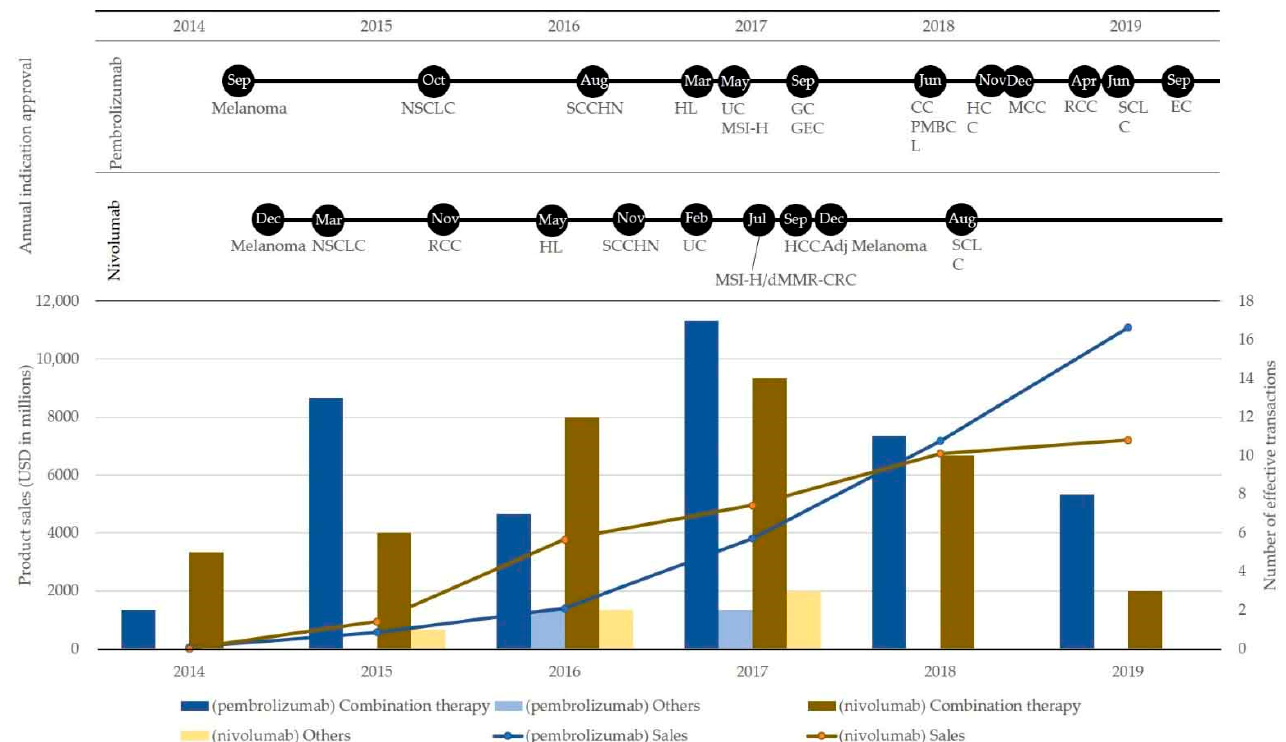
Figure 2. Annual approved indications, annual product sales (line graph), and annual number of effective interorganiza- tional transactions (bar graph) of pembrolizumab and nivolumab from 2014 to 2019. NSCLC: non-small cell lung cancer, SCCHN: squamous cell carcinoma of the head and neck, HL: Hodgkin lymphoma, UC: urothelial carcinoma, MSI-H: microsatellite instability-high, GC: gastric cancer, GEC: gastroesophageal cancer, CC: cervical cancer, PMBCL: primary mediastinal large B-cell lymphoma, HCC: hepatocellular carcinoma, MCC: Merkel cell carcinoma, RCC: renal cell carcinoma, SCLC: small cell lung cancer, EC: endometrial carcinoma, BC: bladder cancer, TMB-H: tumor mutational burden-high, cSCC: cutaneous squamous cell carcinoma, dMMR: mismatch repair deficient, CRC: colorectal cancer, Adj Melanoma: adjuvant treatment of melanoma, ESCC: esophageal squamous cell carcinoma. Effective interorganizational transactions means interorganizational transactions that directly influenced the drug discovery and development of pembrolizumab and nivolumab. Combination therapy: interorganizational transactions for combination therapy development. Others: interorganizational transactions for other